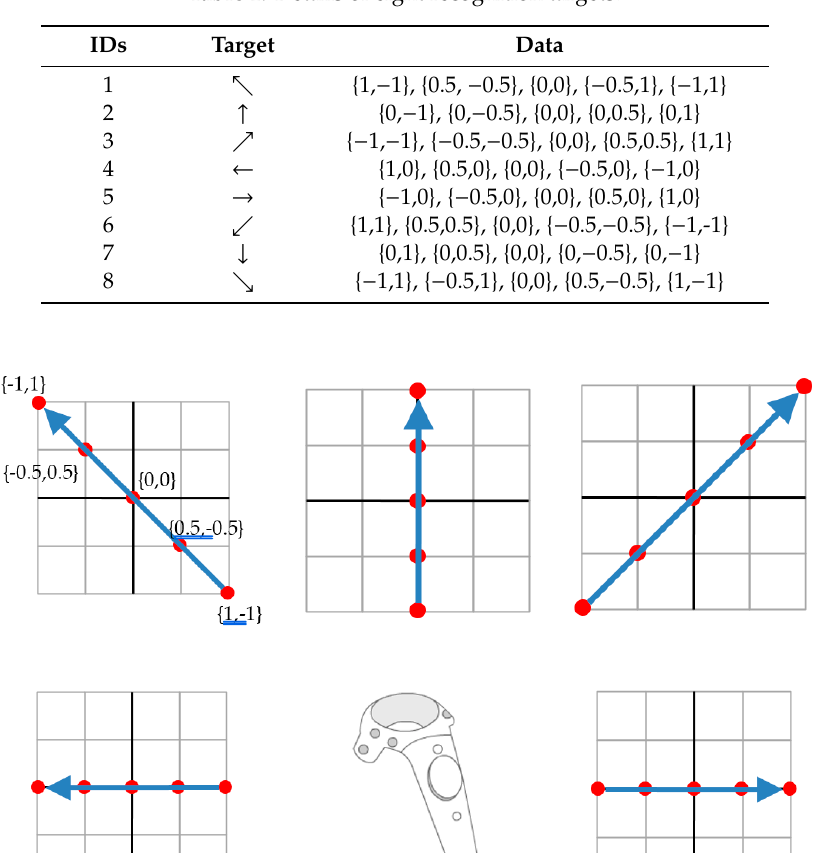
Table 2. Details of four recognition targets for vertical